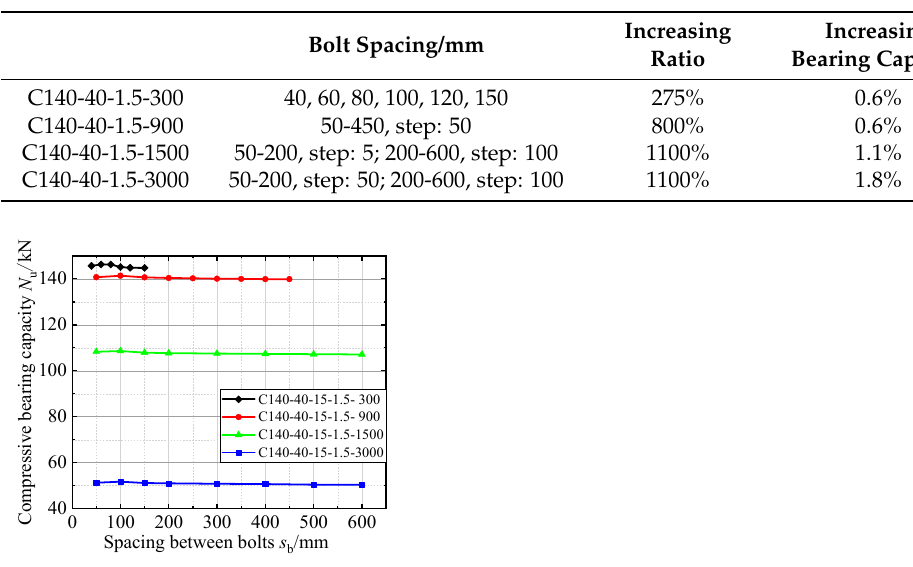
Figure 17. N u - S b relationship curves of the combined columns.